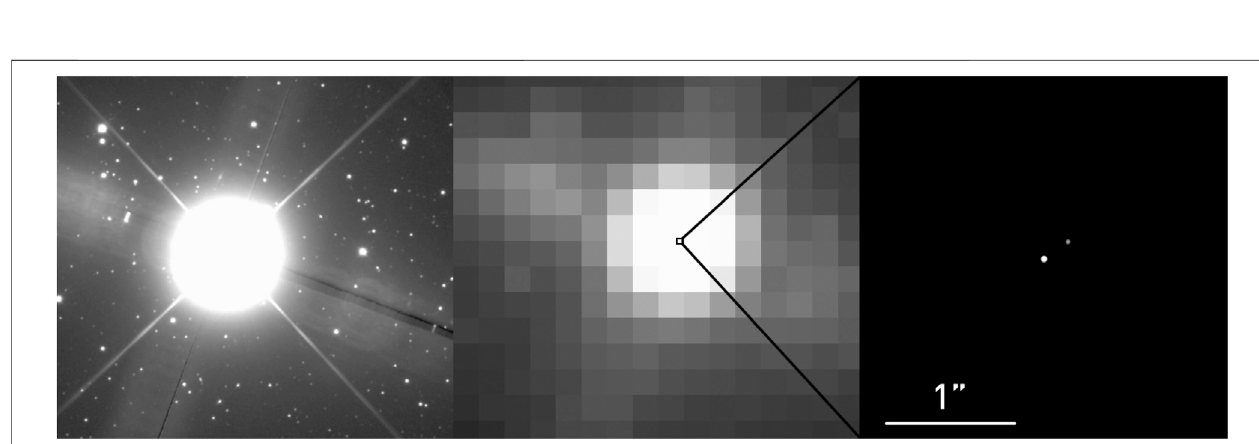
FIGURE8| AnSDSSi-bandimageofthespectroscopicbinarybetaDel left .ThesameSDSSi-bandimagere-sampledtothe21 ″ pixelscaleforTESSwithaninset showingthescaleofthespeckleFoV center .Areconstructed speckleimage right ofthebinaryfrom ‘ Alopeke( ρ (cid:2) 0.225 ″ , Δ m (cid:2) 1.1).Theseimagesillustratethedif fi culty in distinguishing blended sources within the large-scale photometric survey space telescopes like TESS and motivates the high-angular resolution imaging follow-up for exoplanet detections.